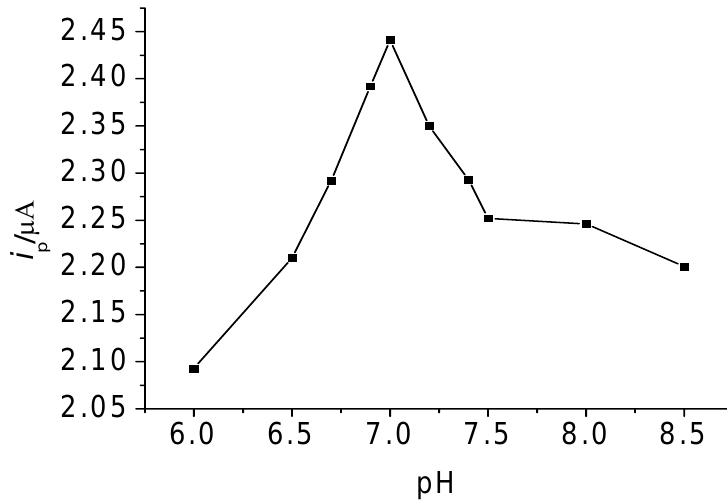
Figure 3. Effect of pH of the buffer solution on the biosensor response was tested with various pH values containing 4.84×10 -5 M H